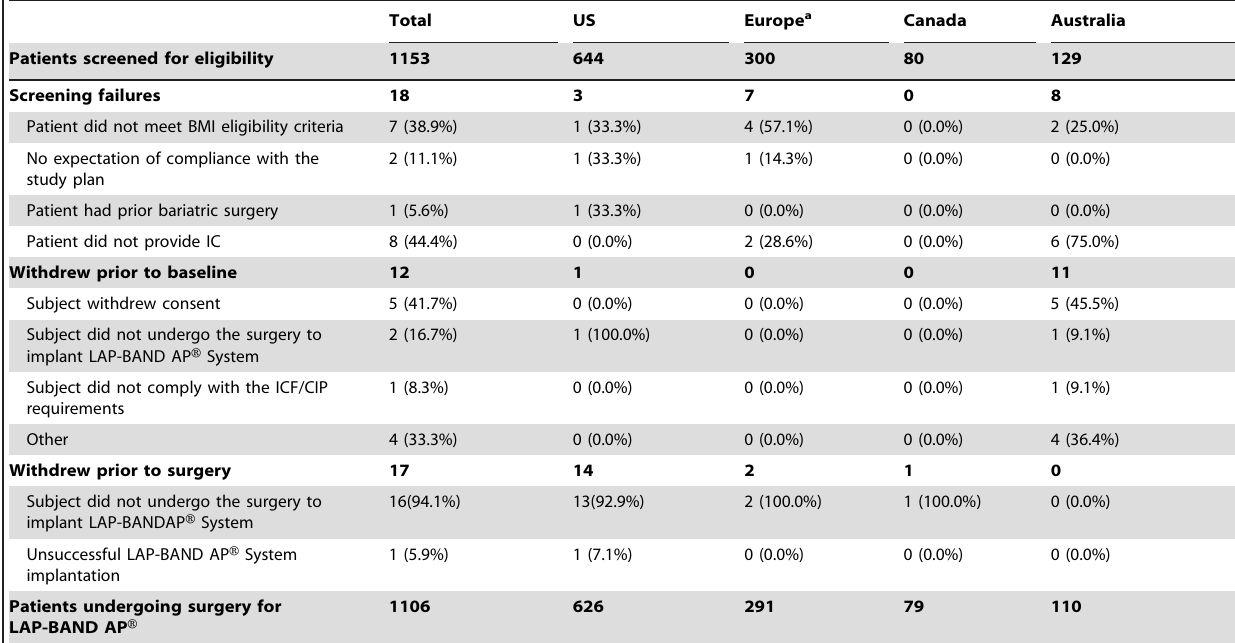
Table 1. Patient Disposition, by